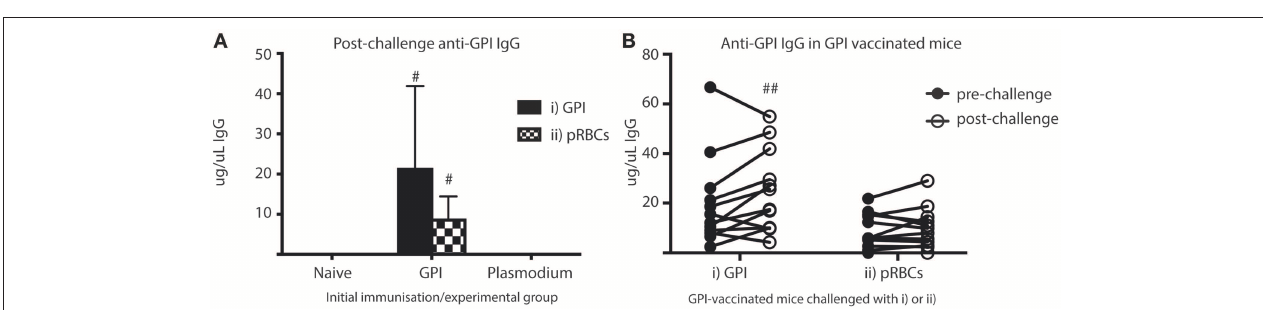
FIGURE 5 | MBC differentiate into ASCs and produce antibodies in vaccinated mice when given GPI-KLH or pRBCs, and in Plasmodium mice when given a third dose of pRBCs. Mice were vaccinated and boosted with GPI-KLH ( n = 24) or infected twice with pRBCs i.p . ( n = 24, referred to as Plasmodium mice). Naïve mice were included as a control group ( n = 24). After resting for a minimum of 10 weeks, mice were injected with GPI-KLH i.p. ( n = 12 from each group) or 1 × 10 5 pRBCs i.p. ( n = 12 from each group) to assess reactivation of MBCs and differentiation into ASCs at day 5 using ELISPOTs. (A) Denotes the proportion of GPI-specific ASCs/1 × 10 6 cells for challenge with synthetic GPI (closed circle) or pRBCs (open square). (B) Denotes the proportion of total ASCs/1 × 10 6 cells for challenge with synthetic GPI (closed circle) or pRBCs (open square). Pooled data from all experimental mice are represented as median ± 95%-CI. Data was analyzed using the non-parametric Kruskal-Wallis test and differences determined by Dunn’s multiple comparisons test. Significance was determined at P < 0.05. # GPI-specific ASCs in spleens of GPI-vaccinated mice statistically higher than naïve and Plasmodium mice when challenged with both GPI or pRBCs ( P < 0.05); ## total IgG in spleens of Plasmodium mice statistically higher than naïve and GPI mice when challenged with pRBCs ( P < 0.01).